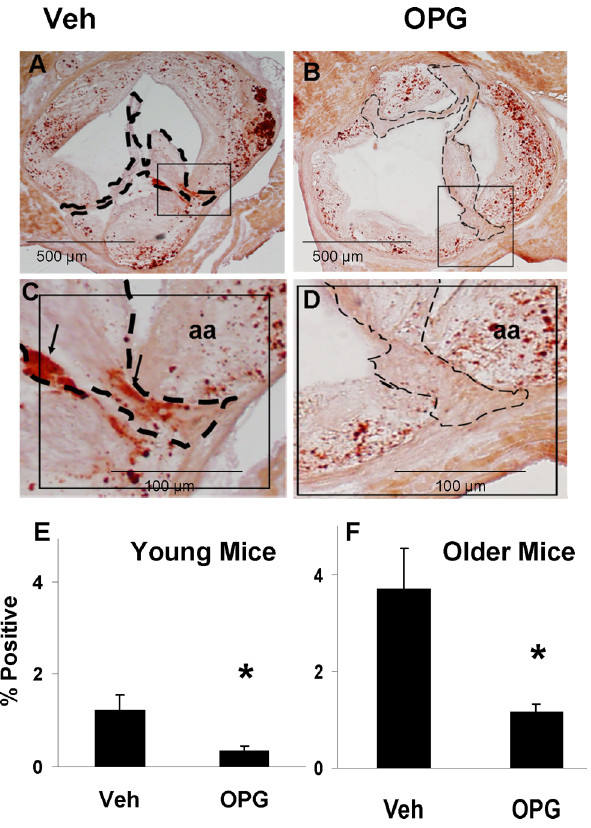
Figure 4. Calcification in the aortic valve. Alizarin Red staining in a valve from an Older vehicle-treated mouse ( A,C ) demonstrates bright red staining, indicating valve calcification (arrows). Valve cusps are thickened in an Older OPG-treated mouse, but are minimally calcified ( B,D ). Dashed borders contain valve cusps, with care taken to exclude the aortic annulus (aa). Group data for valve calcification in Young mice (E) and Older mice (F). *p , 0.05 Veh vs. OPG, N=12.